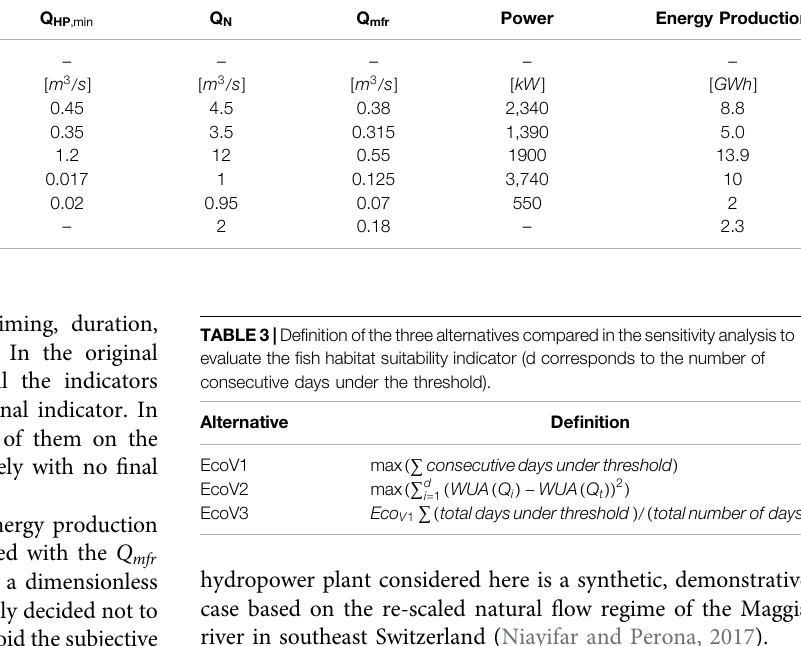
TABLE 2 | Parameters of the six case studies compared for the sensitivity analysis. Location